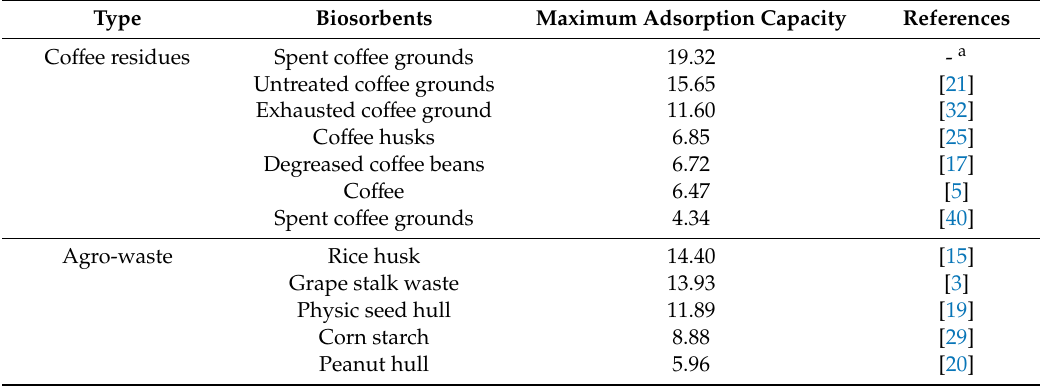
Table 3. Maximum Cd adsorption capacities (q m , mg g − 1 ) of spent co ff ee grounds calculated based on Langmuir isotherm and those of other agro-waste materials reported in